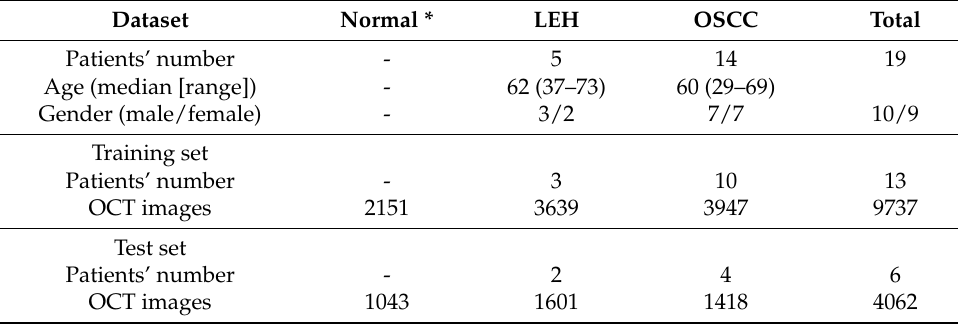
Table 1. Information of the patients and the partitioning of the data set.